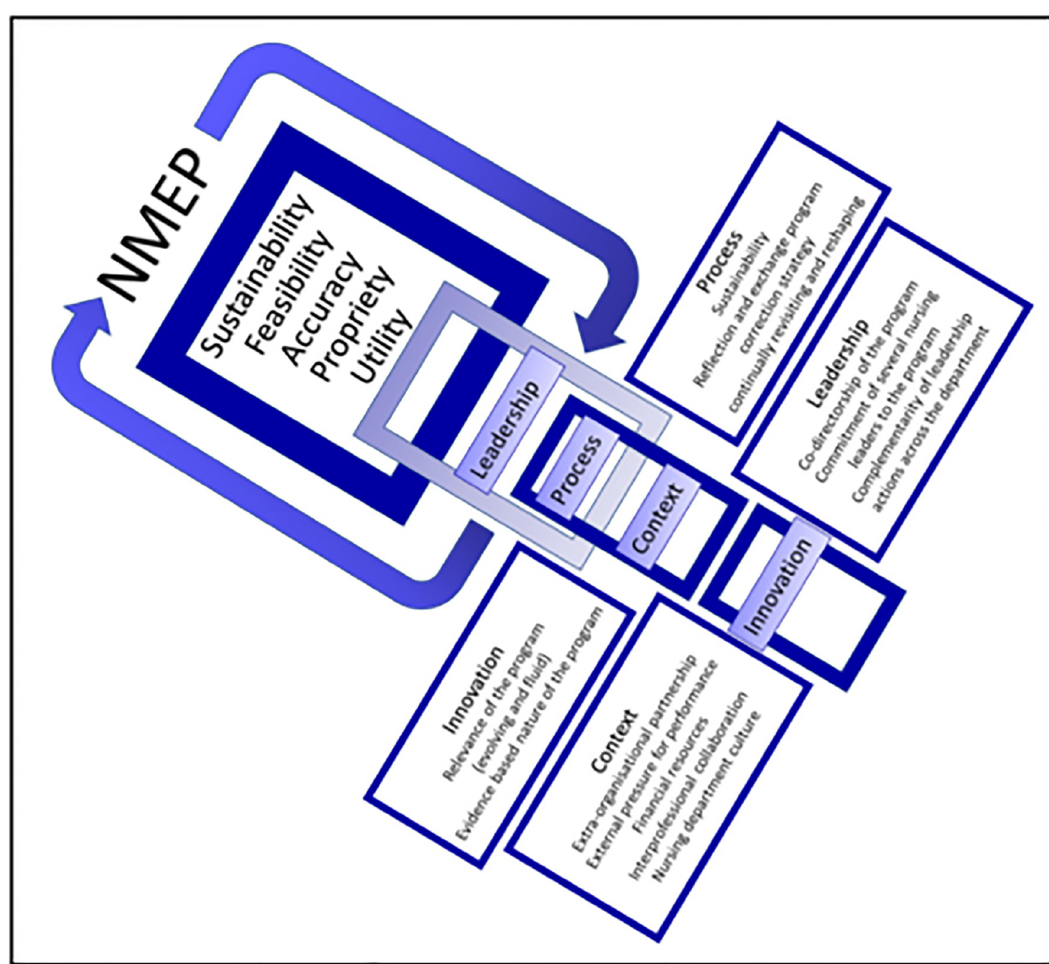
Fig 2. NMEP sustainability